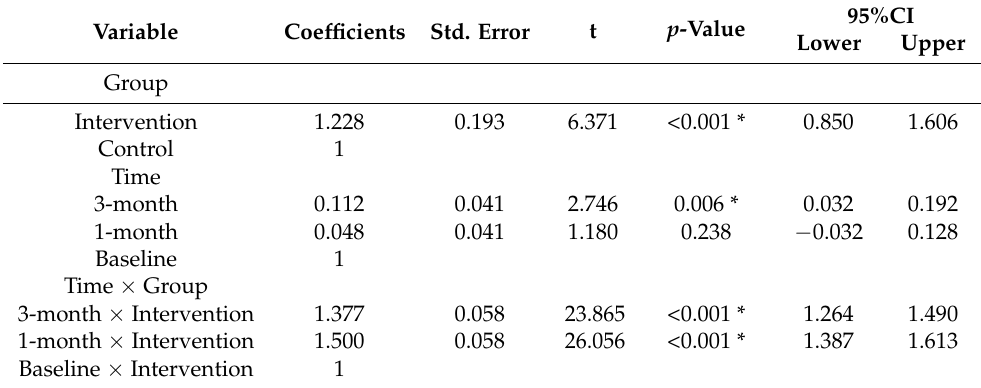
Table 3. Fixed coefficient of variables for condom use frequency (ITT).